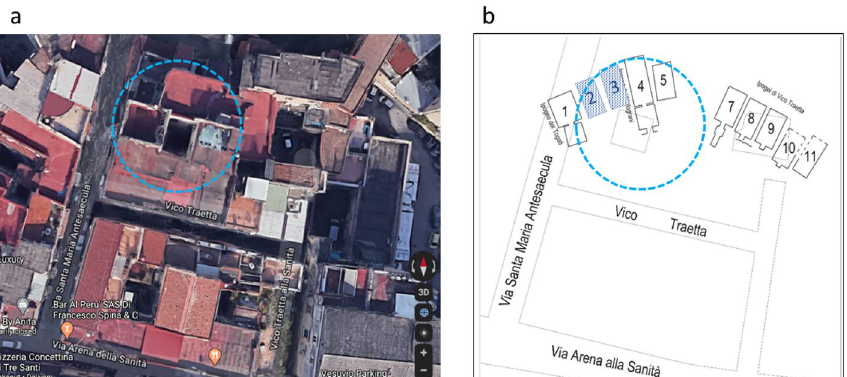
Figure 1. ( a ) Foreground top view of the studied site as seen with Google Maps 25 . The dashed circle corresponds to the region explored in this paper by the muography technique with two detectors. ( b ) Schematic drawing of the underground level at the depth of 10 m with Greek funeral chambers numbered from 1 to 11. Scale and orientation in ( a ) and ( b ) are the same. Chambers 2 and 3 are unknown and their existence was hinted by the integrated site topology reconstructed with 3D surveys. (Satellite imagery: Google © 2022 Imagery date 7/29/2020).